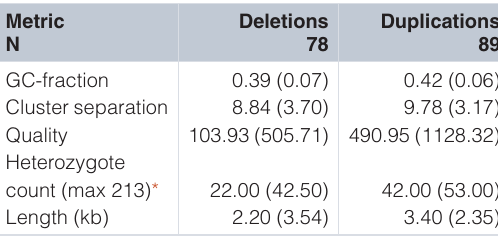
Table 2. Quality metrics for Genomestrip